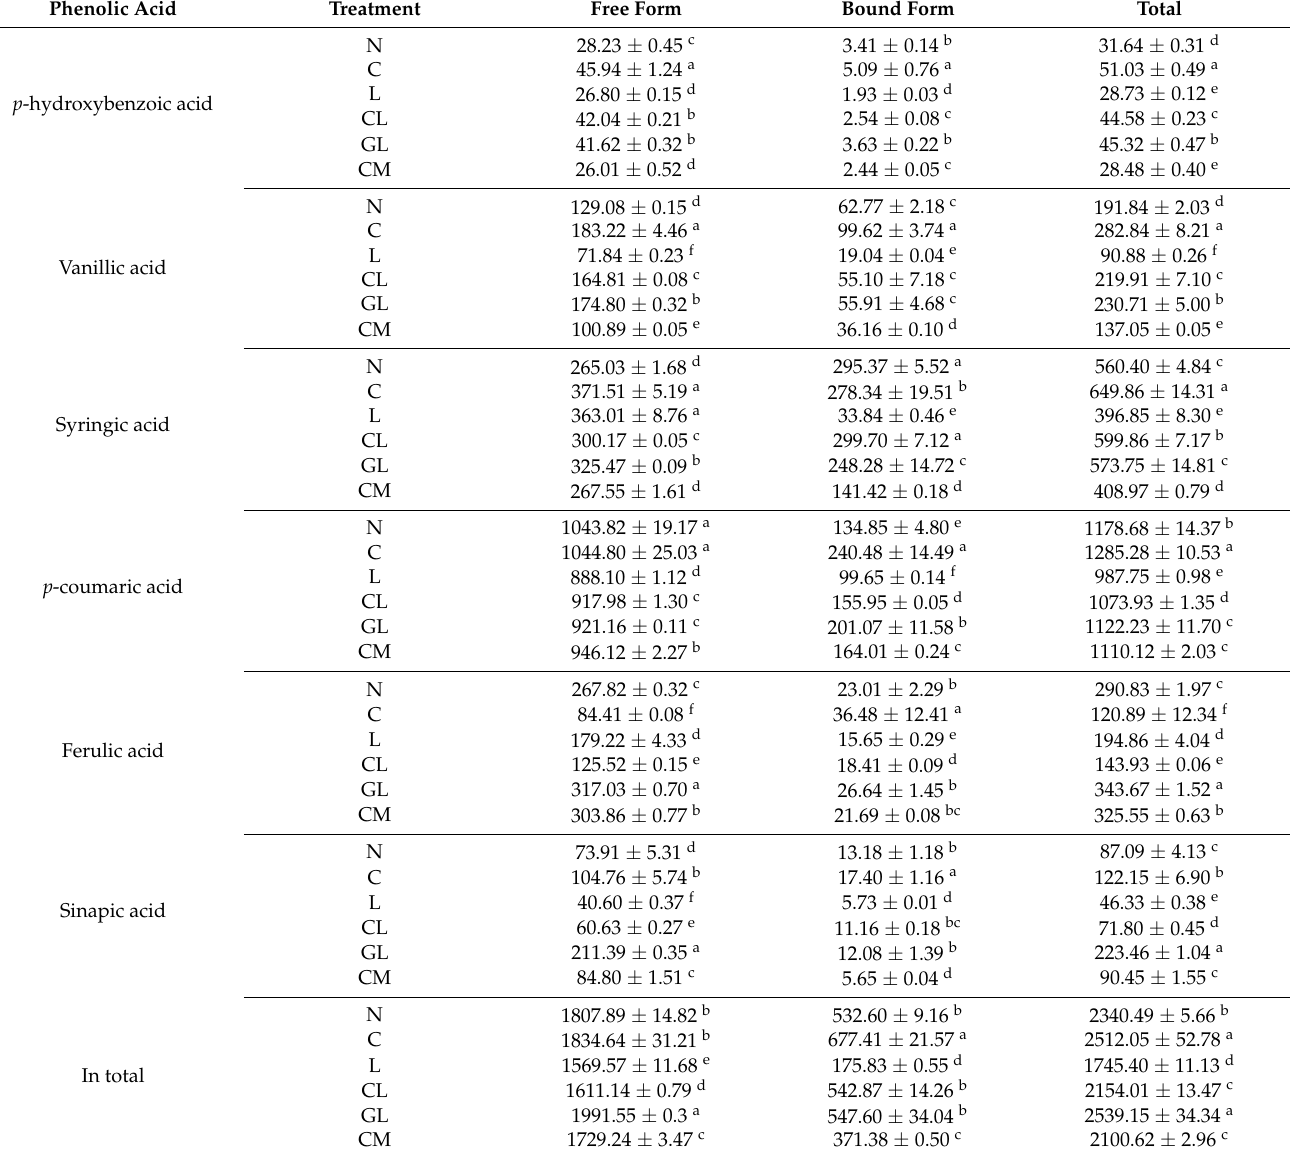
Table 1. Contents of individual and total phenolic acids ( µ g/g DW) during germination (n = 3) in soybean